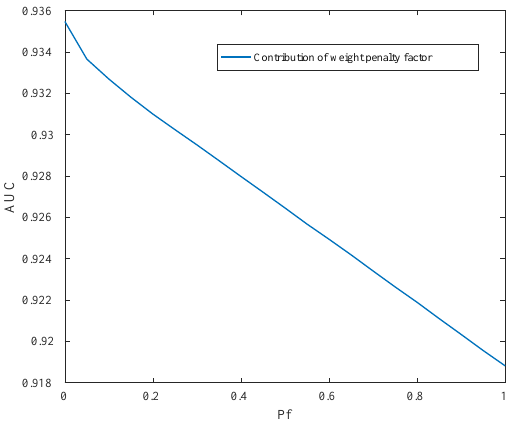
Figure 16. The effect of the weight penalty factor, Pf , in anomaly detection for San Diego airport HSI image. Table 5. AUC values and processing time of different methods for the San Diego airport HSI image